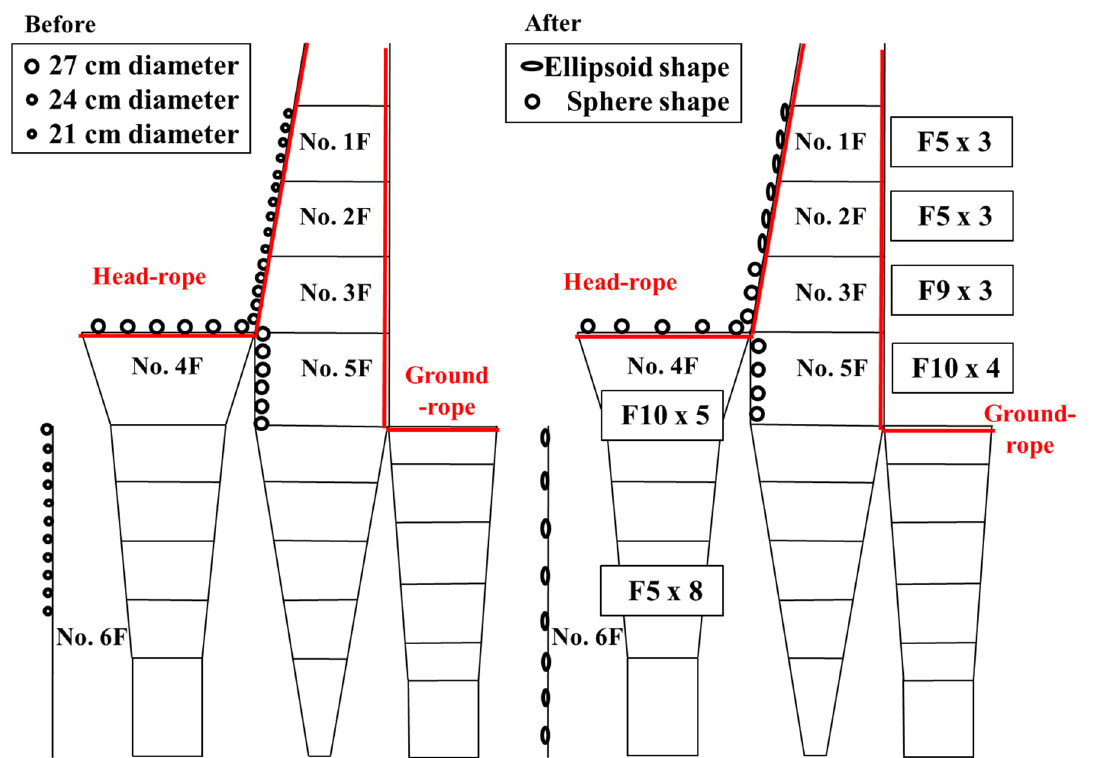
Figure 11. The comparison between conventional design and suggested design of float parts in the pair trawl fishery gear for lower drag. Conventional design used all sphere shape float. In suggested design, ellipsoid-shaped floats (F5) were arranged in float parts with low attack angle in 0°~30°. And small numbers of lager floats were rearranged from many numbers of smaller floats. Sphere-shaped floats were used in the conventional design as shown in Figure